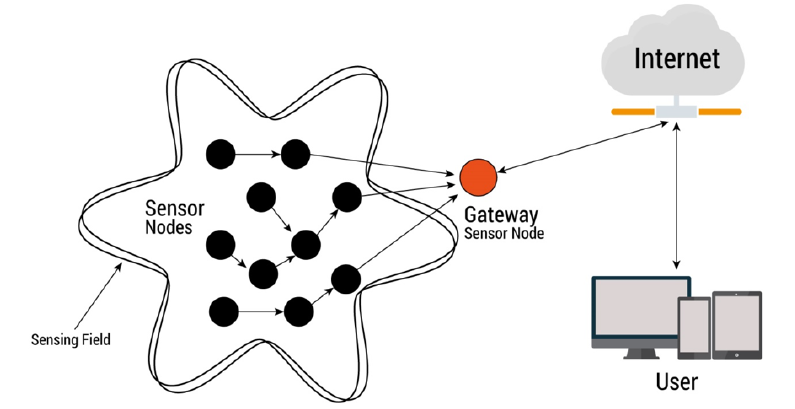
Figure 6. Wireless sensor network architecture of the IoT system.